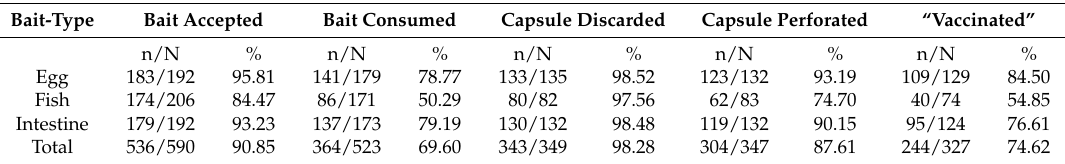
Table 2. Summary of bait acceptance (“direct oral contact”), consumption and handling, fate of capsule and final assessment if liquid was released in the oral cavity of the dog (“vaccinated”). Except for bait acceptance and consumption, all numbers are based on dogs that (partially) consumed the bait after it was accepted.